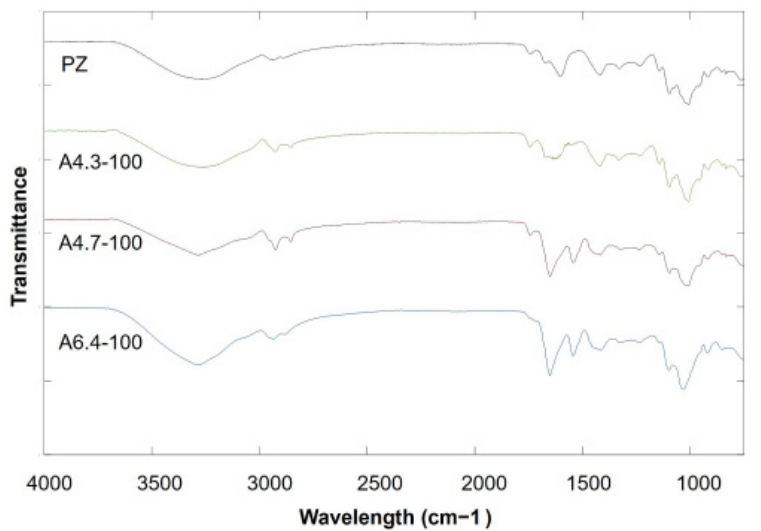
Figure 4. FT-IR spectra of the hydrogels.